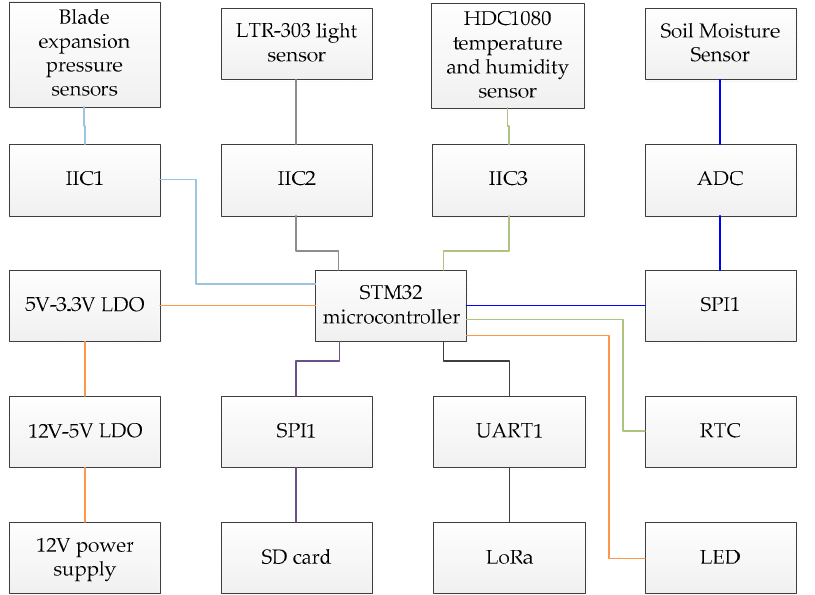
Figure 4. System simplified circuit diagram.